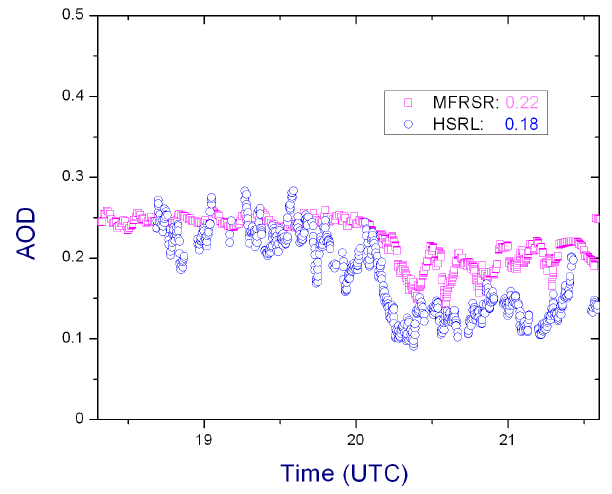
Fig. 8. Temporal realizations of the MFRSR- and HSRL-derived AOD along the HSRL track. Corresponding mean values (0.22 and 0.18) are